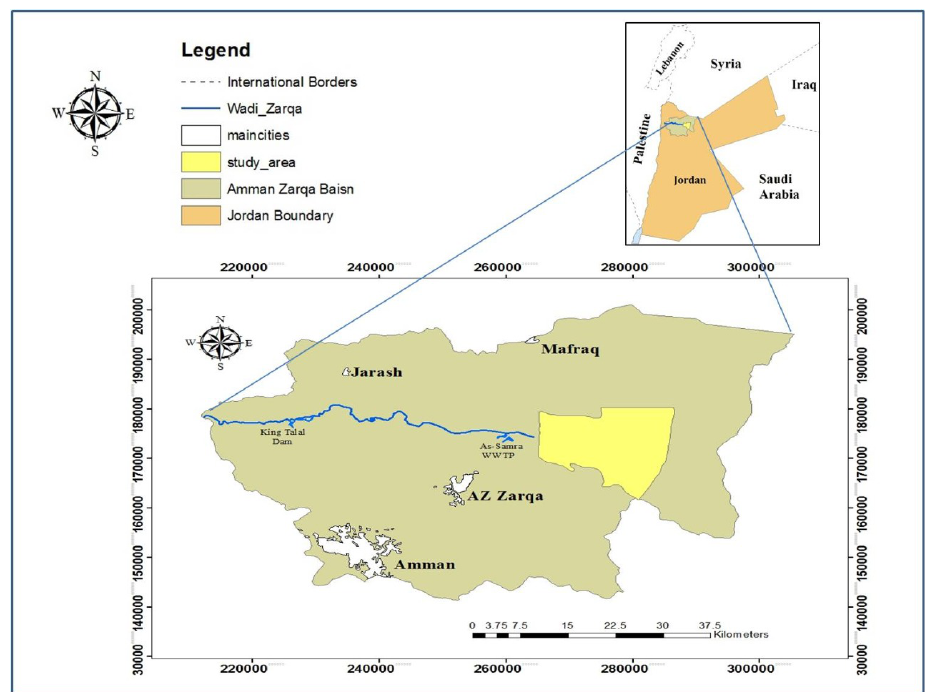
Figure 1. Location map of the study area. The climate of this area is characterized by warm summers and cold winters (i.e., Sahara type), with average precipitation in the range of 120 mm/year in the southeastern part to 160 mm/year in the northwest area. The monthly rainfall distribution has the highest values during the rainy season in December (an average of 29 mm) and January (an average of 33 mm), and a sharp decrease occurs between March and May (4–20 mm). The monthly variation in temperature peak up in July (min 18 ◦ C, max 44 ◦ C, average 28 ◦ C) and decrease in January (min 5 ◦ C, max 23 ◦ C, average 10 ◦ C). The annual surface evaporation rate, based on a class-A-pan test, ranges from 2450 to 3850 mm/year with an average value of 2949 mm/year, varying between. The monthly evaporation rate ranges from 116 mm in January to 395 mm in July. Most of the rainfall occurs during very short intervals and forms flash flooding events. The volume of runoff in this area was estimated using the runoff coefficient for wet, dry, and average conditions to be 2.2 MCMY